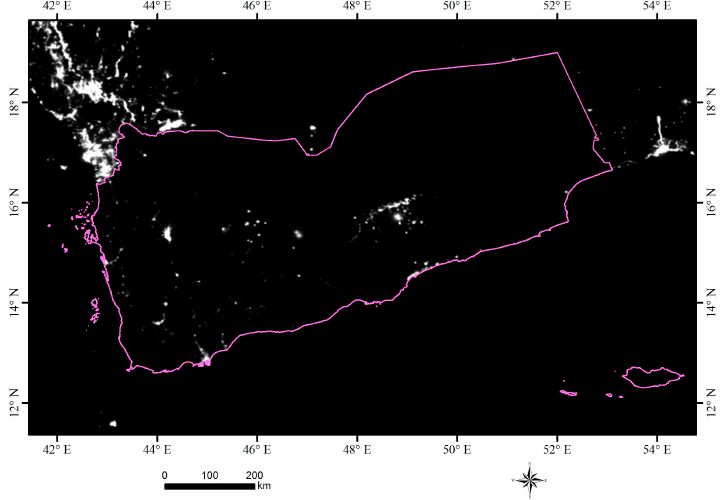
Figure 4. DMSP-OLS nighttime light images of Yemen from 2013.